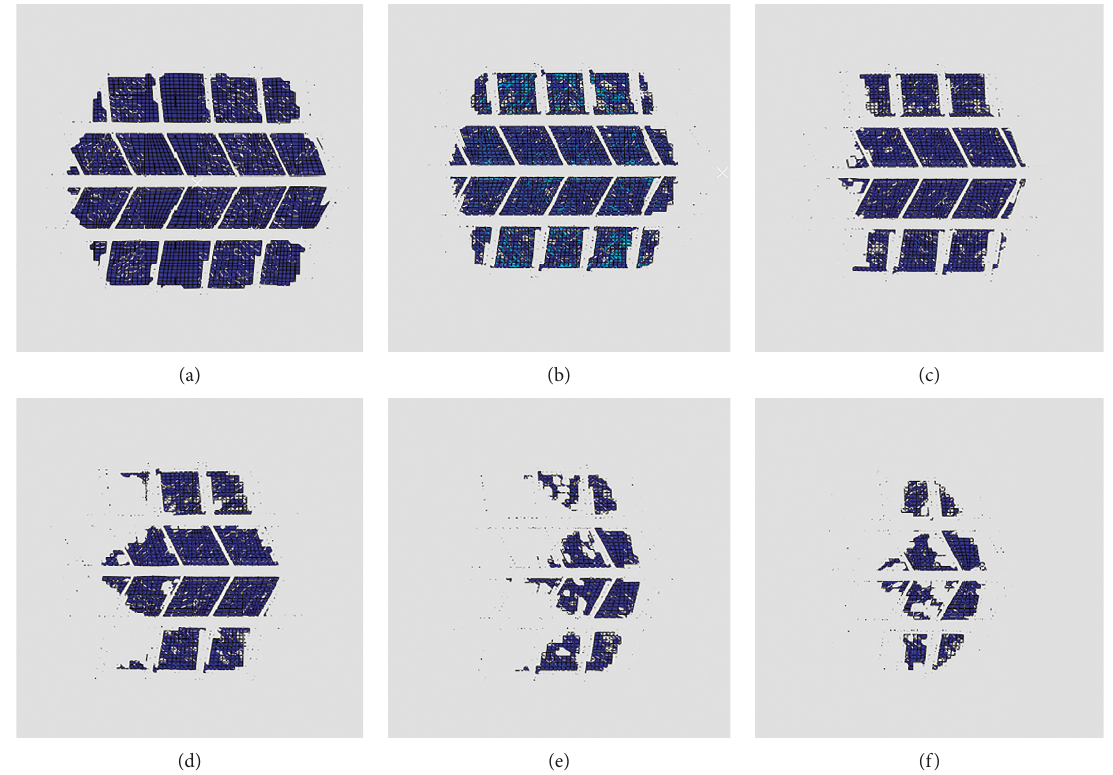
Figure 5: Footprint at tire-pavement interface in the process of tire hydroplaning: (a) t (e) t 7.015s; (f) t (cid:31)